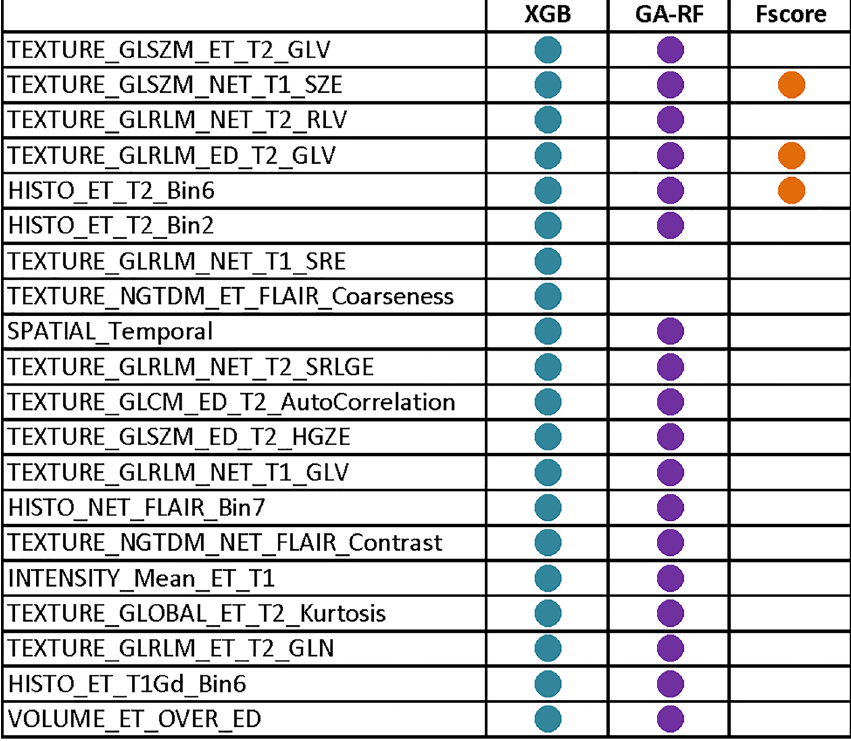
Figure 5. Common radiomics features selected by different methods. Solid circles represent the presence of certain features in each feature set.